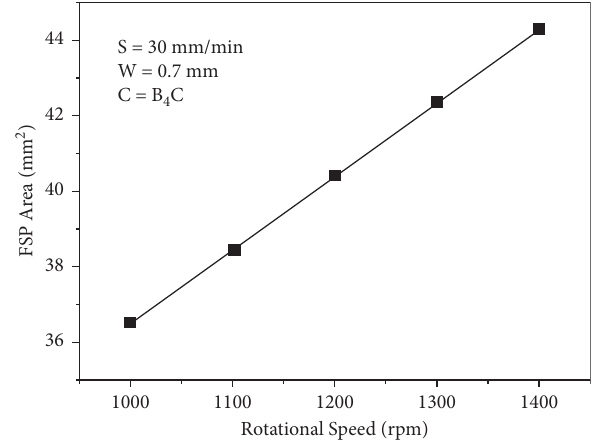
Figure 6: Variations in stir area of CuNi/B a function of tool rotational